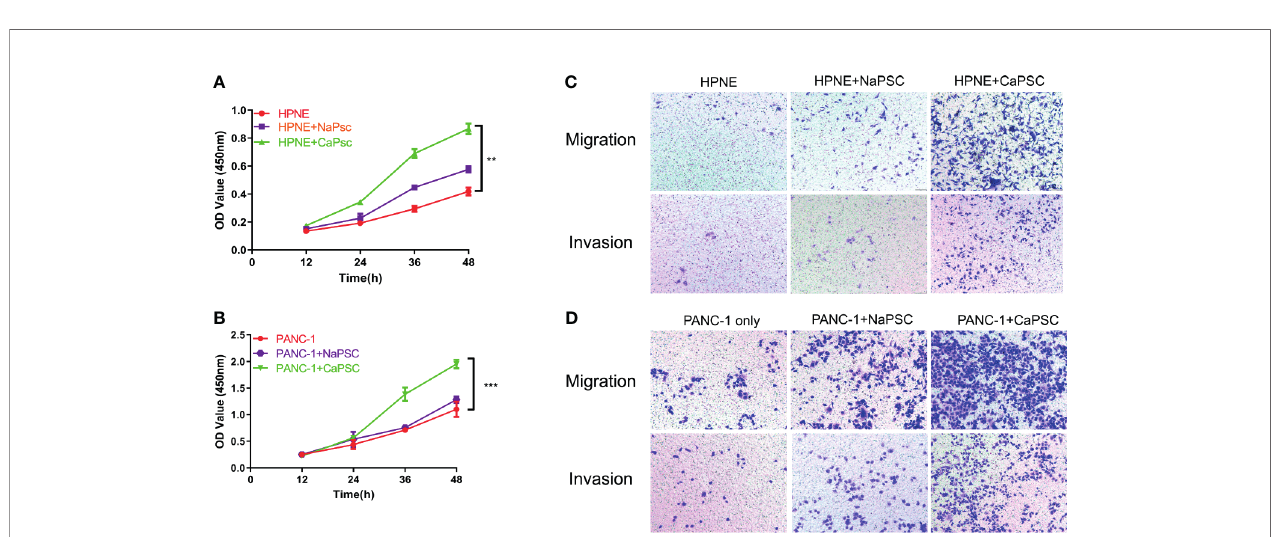
FIGURE 2 | Co-culture with CaPSCs enhanced the proliferation, invasion and migration of HPNE and PANC-1 cells. (A) CCK-8 proliferation assay after co-culture of HPNE cells with NaPSCs or CaPSCs. (B) CCK-8 proliferation assay after co-culture of PANC-1 cells with NaPSCs or CaPSCs. (C) Transwell migration and invasion assays after co-culture of HPNE cells with NaPSCs or CaPSCs. (D) Transwell migration and invasion assays after co-culture of PANC-1 cells with NaPSCs or CaPSCs. **P < 0.01, ***P <